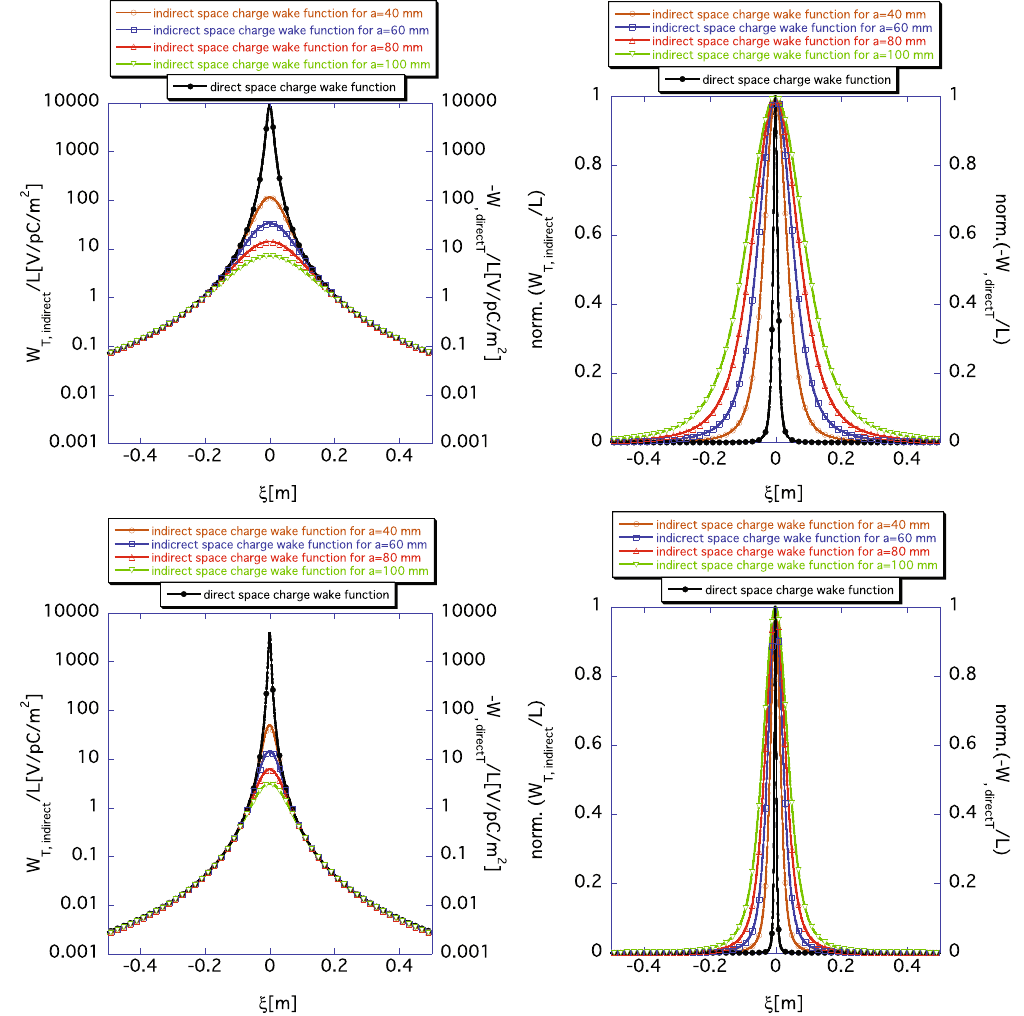
Figure 5. Dependence of indirect space-charge wake function W T , indirect ( ξ ) on chamber radius a according to Eq. (25), where σ z = 0 and r b = 10 mm. The brown, purple, red and green lines (read using the scale markings on the left axis) show the results for a = 40 mm, 60 mm, 80 mm, and 100 mm, respectively. The black line (read using the scale marking on the right axis) shows the direct space-charge wake function W T , direct ( ξ ) obtained using Eq. (24) as a reference. The upper and lower panels show the functions W T , indirect ( ξ ) and W T , direct ( ξ ) for β = 0.1, and for β = 0.9, respectively. The panels on the right show the normalized (to the same amplitude) versions of the panels on the